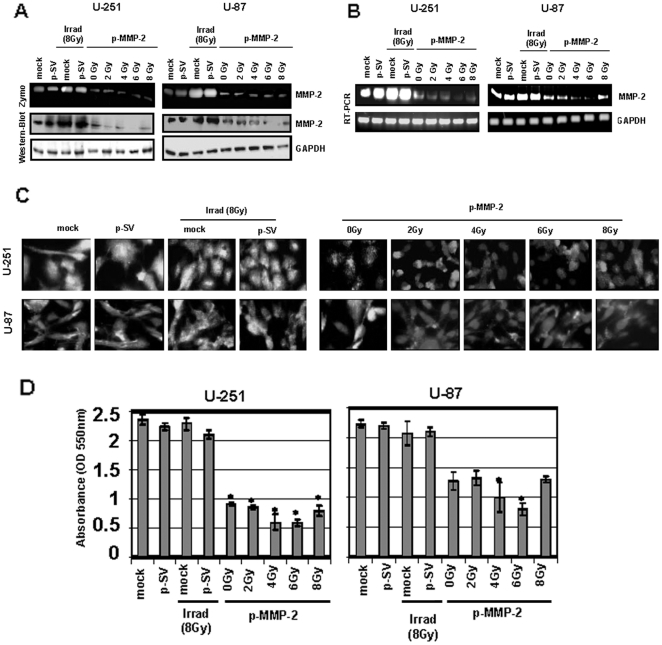
p-MMP-2 transfection inhibits radiation-enhanced MMP-2 activity and expression levels as well as cell viability.
A, U-251 and U-87 cells were transfected with mock (PBS), p-SV or p-MMP-2 (2 µg), and after 72 h of incubation, cells were irradiated with 0, 2, 4, 6 or 8 Gy and incubated for a further 24 h. Conditioned media was used to determine MMP-2 activity by gelatin zymography, and total cell lysates were used to determine MMP-2 levels by Western blotting. B, Total RNA was used to determine MMP-2 mRNA transcription levels by RT-PCR with gene-specific primers. GAPDH served as a loading control. C, U-251 and U-87 cells were transfected with mock, p-SV or p-MMP-2 and irradiated as described above. 24 h after radiation, the cells were fixed and processed to visualize MMP-2 expression. The cells were mounted using mounting media with DAPI to visualize the nucleus. D, U-251 and U-87 cells were transfected with mock, p-SV or p-MMP-2, and irradiated for 72 h after transfection. After a another 24 h of incubation, cell viability was analyzed by MTT assay (absorbance read at 550 nm). Columns: mean of triplicate experiments; bars: SD; *p<0.01, significant difference from mock, p-SV or irradiated controls.